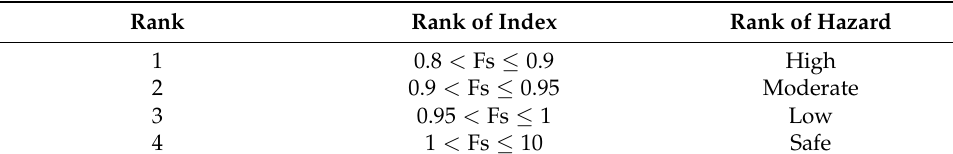
Table 3. Hazard classification.